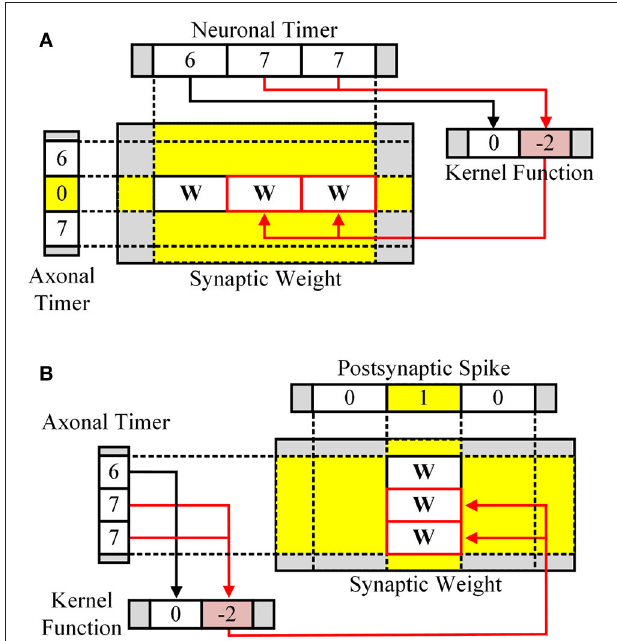
FIGURE 2 | Learning stage for (A) pre-then-post spikes and (B) post-then-pre spikes.